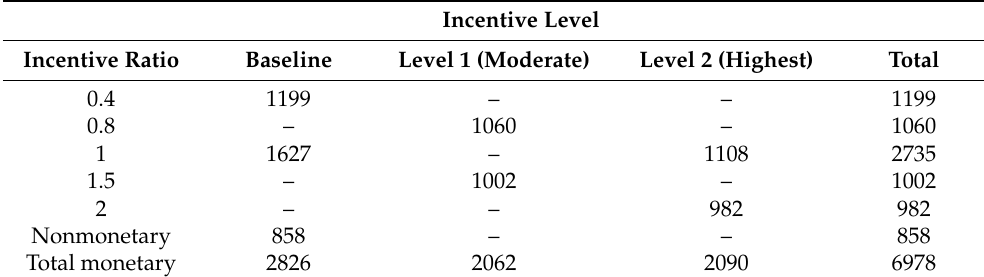
Table 4. Numbers and types of Incentives awarded to study participants from 77 participating farmers’